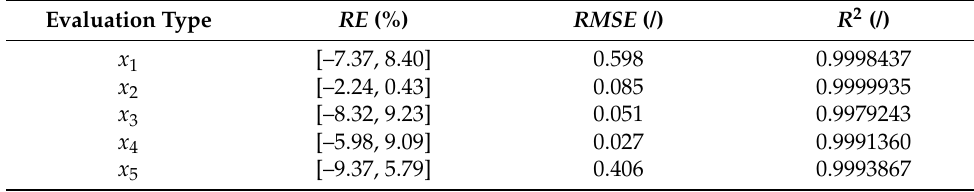
Table 4. Accuracies of the PRS